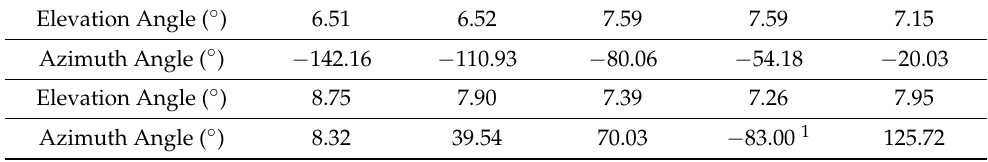
Table 11. DOA estimation of nearby outer race by CPCMA-ESPRIT for rolling element fault signal at 290